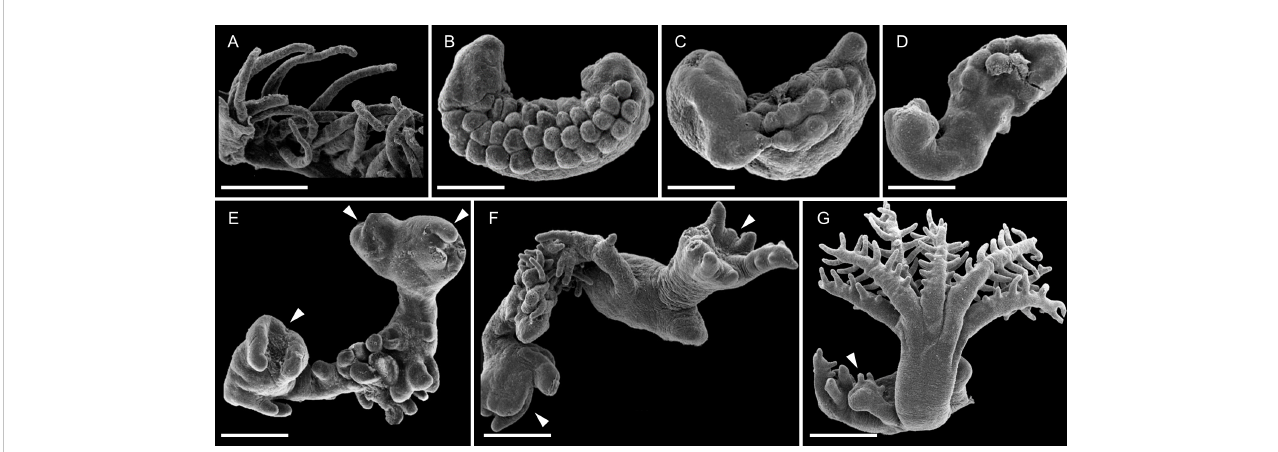
FIGURE 4 SEM images of whole-body-regeneration from excised tentacles of Xenia umbellata fi rst into polyps and then into miniature colonies. (A) Day 0 post- amputation from polyp. Close-up of an amputated tentacle, showing elongated pinnules. (B-D) Days 3, 5, 7. Tentacles undergo morphological dedifferentiation to form smooth tissue. (E) Day 10. Polyp buds form on various parts of the tentacle. (F) Day 13, partially regenerated polyp with mouth visible and tentacles elongating. (G) Day 17, fully regenerated polyp with another bud forming. Scale bars 0.5 mm. Arrowheads indicate developing